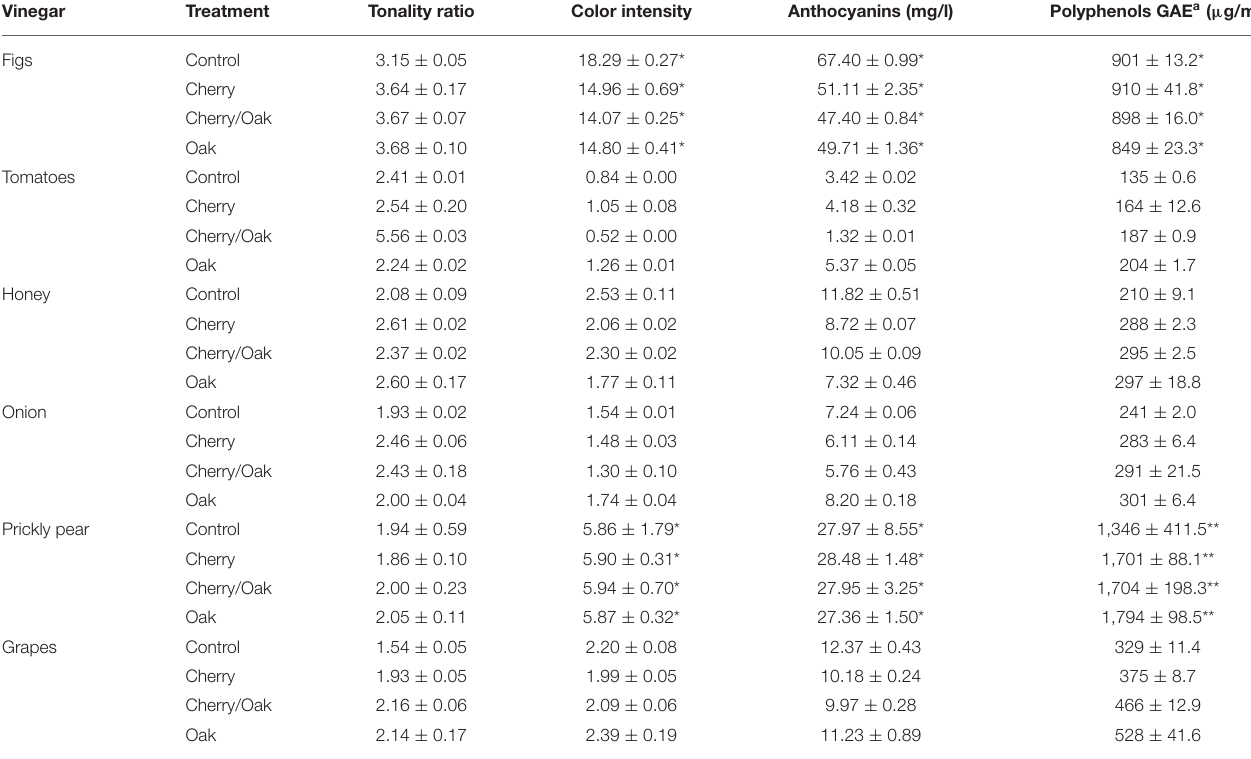
TABLE 5 | Tonality ratio, color intensity, anthocyanin (mg/l), and polyphenolic ( µ g/ml) contents for the accelerated wood-aged vinegar samples.